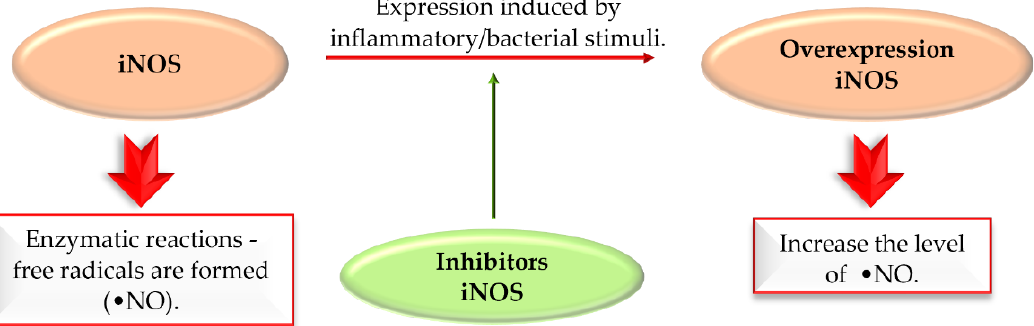
Figure 37. The action of iNOS enzyme and iNOS inhibitors in Parkinson ’ s disease.